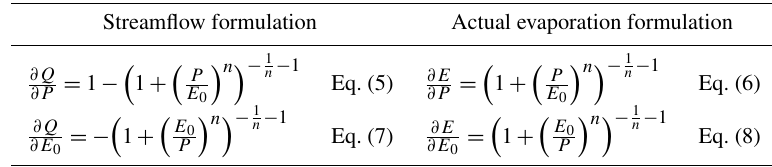
Table 2. Partial derivatives of the Turc–Mezentsev formula ( P – precipitation, Q – streamflow, E 0 – maximum evaporation, E – actual evaporation, all in mmyr − 1 averaged over many years). n is the free parameter of the Turc–Mezentsev formula ( n > 0).